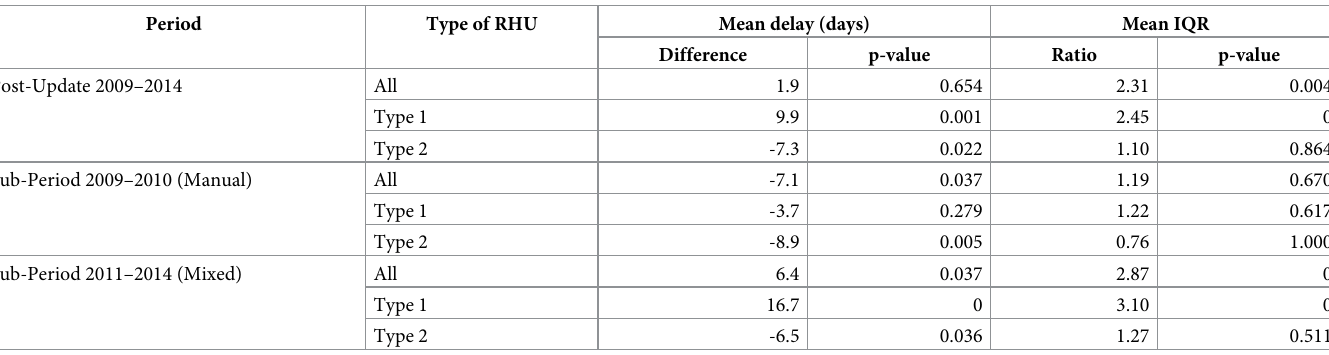
Table 3. The difference in mean delays and the ratio of mean IQRs.